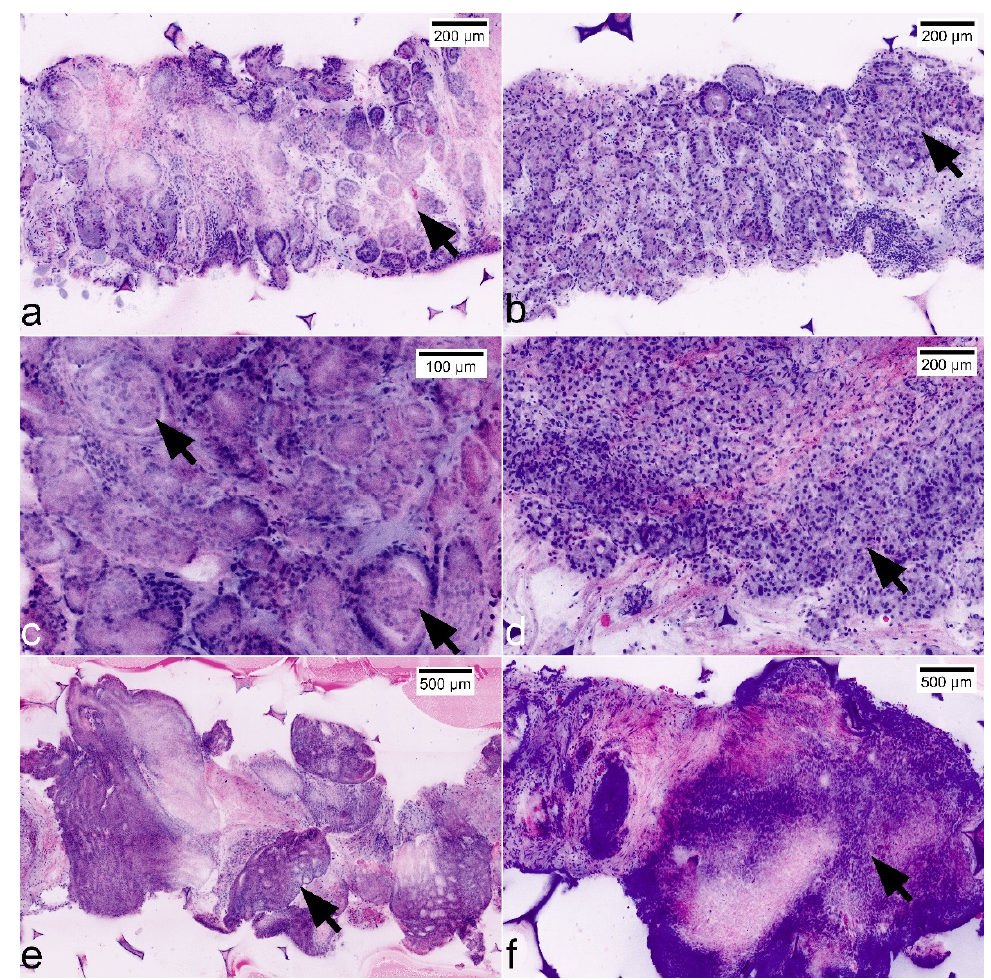
Figure 5. Representation of GLEASON patterns and ISUP grades in FCM scans. ( a ) GLEASON